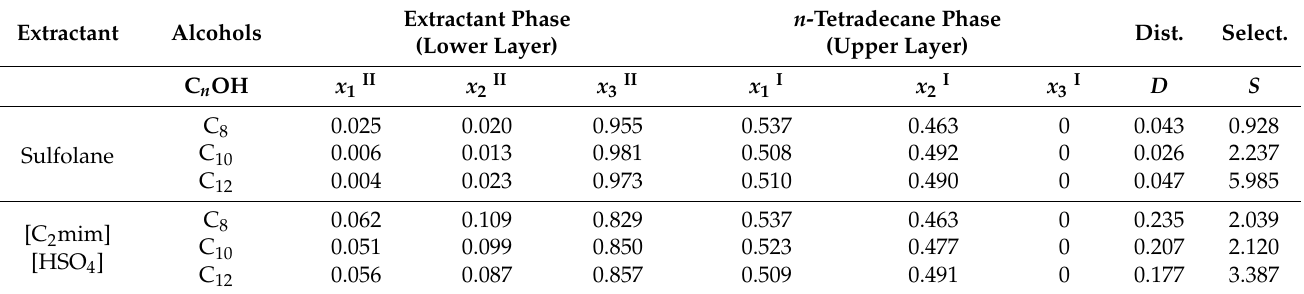
Table 2. Solubility (mole fraction), selectivity (S) and distribution ratios (D) for detergent alcohol/ n - tetradecane mixtures contacted with extraction solvents sulfolane and ionic liquid [C 2 mim][HSO 4 ] at 295 K and at 101 kPa a